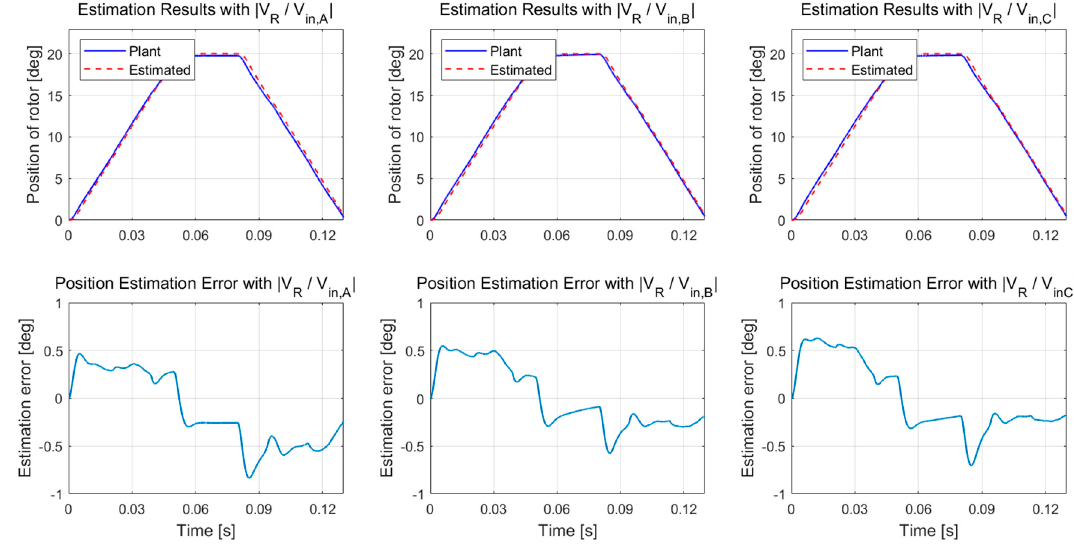
Figure 16. The position estimation results of each measurement of v R to v in,A , v in,B , and v in,C based on UKF.